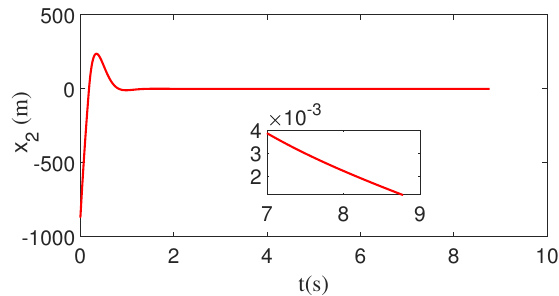
Figure 3. The change in ZEM with constant maneuver.